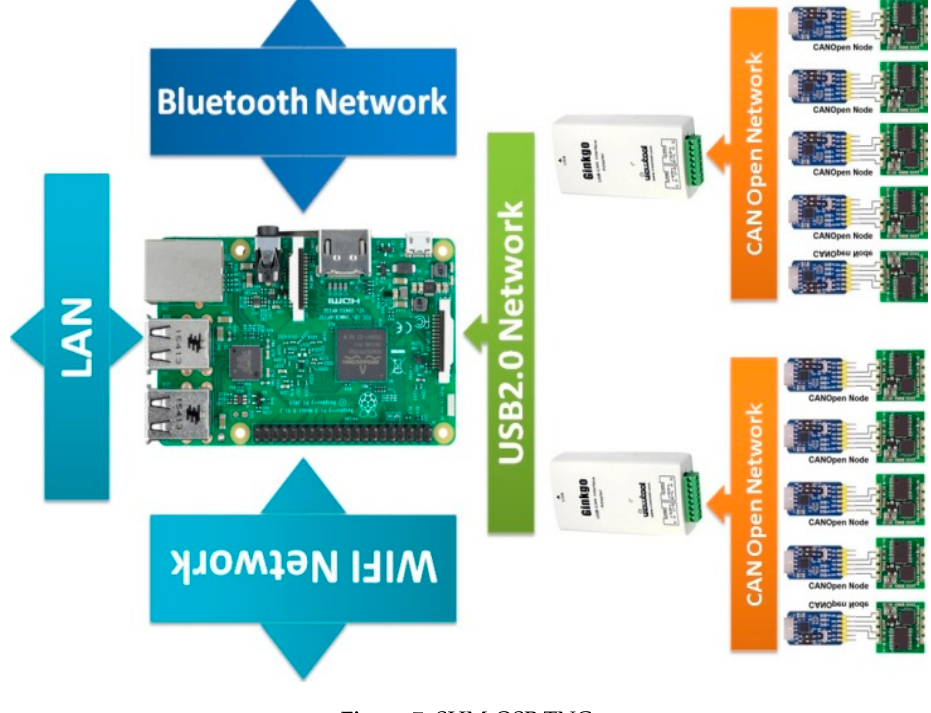
Figure 7. SHM ‐ OSB TNC. Figure 7. SHM-OSB